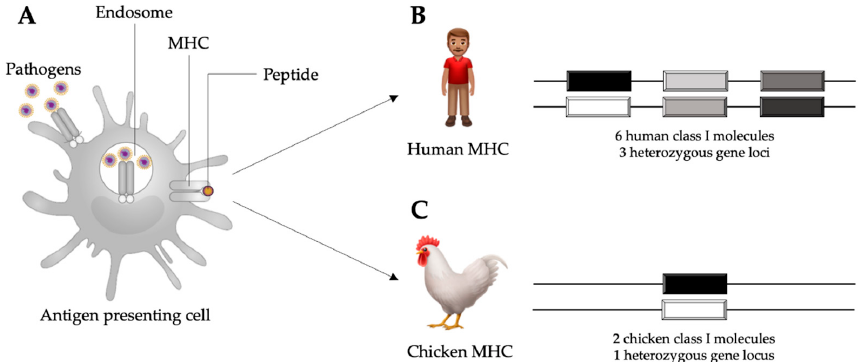
Figure 1. Schematic representation of an antigen presenting cell internalizing pathogens in the process of phagocytosis and subsequent antigen presentation through major histocompatibility complex (MHC) molecules ( A ). In humans, there are six MHC class I molecules occurring in three heterozygous loci ( B ). In chickens, there are two MHC class I molecules occurring in one heterozygous locus ( C ), which allows for stronger associations with disease resistance than the human MHC class I. Adapted from Kaufman, 2013 [19].